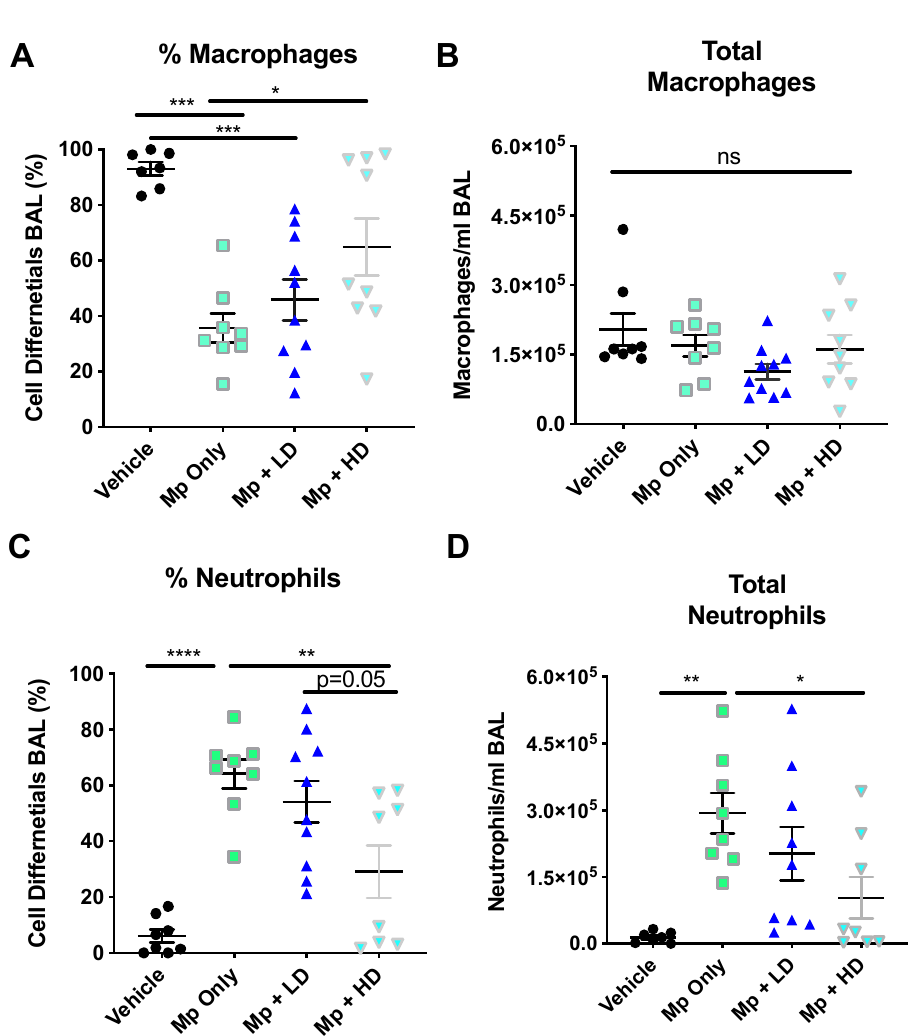
Figure 1. The effect of Ang-(1–7) on inflammatory cell recruitment in Mycoplasma pneumoniae – challenged BALB/c mice. A–D) Mice were infected with Mp (or vehicle control) and 2 h later were treated with Ang-(1–7) at high (1 mg/kg body weight) or low (0.3 mg/kg body weight) doses. Total cells present in the BALF were assessed by differential staining. ( A ) The percentage, ( B ) total macrophages, ( C ) the percentage, and ( D ) total neutrophils present in the BAL 24 h post infection are reported. Data are expressed in mean ± SEM. n = 8–10 mice/group, two independent experiments combined. * p < 0.05, ** p < 0.01, *** p < 0.001, **** p < 0.0001 by one-way ANOVA for multiple com- parisons.